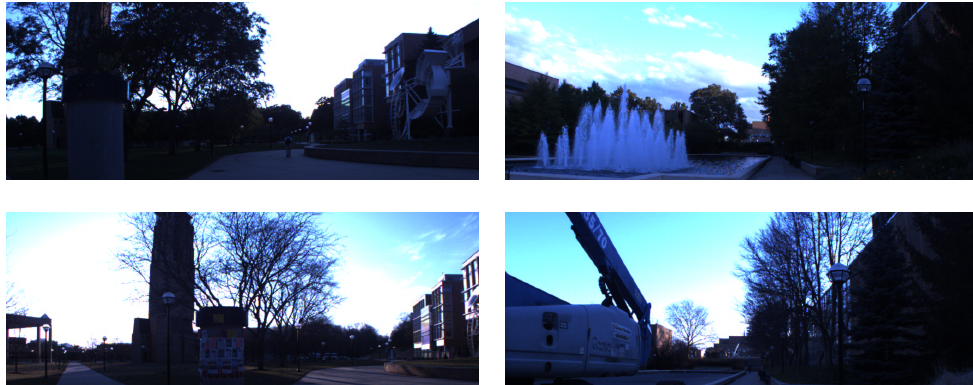
Figure 6. Examples of the Carlevaris dataset with seasonal variations ( left ) as well as structural changes ( right